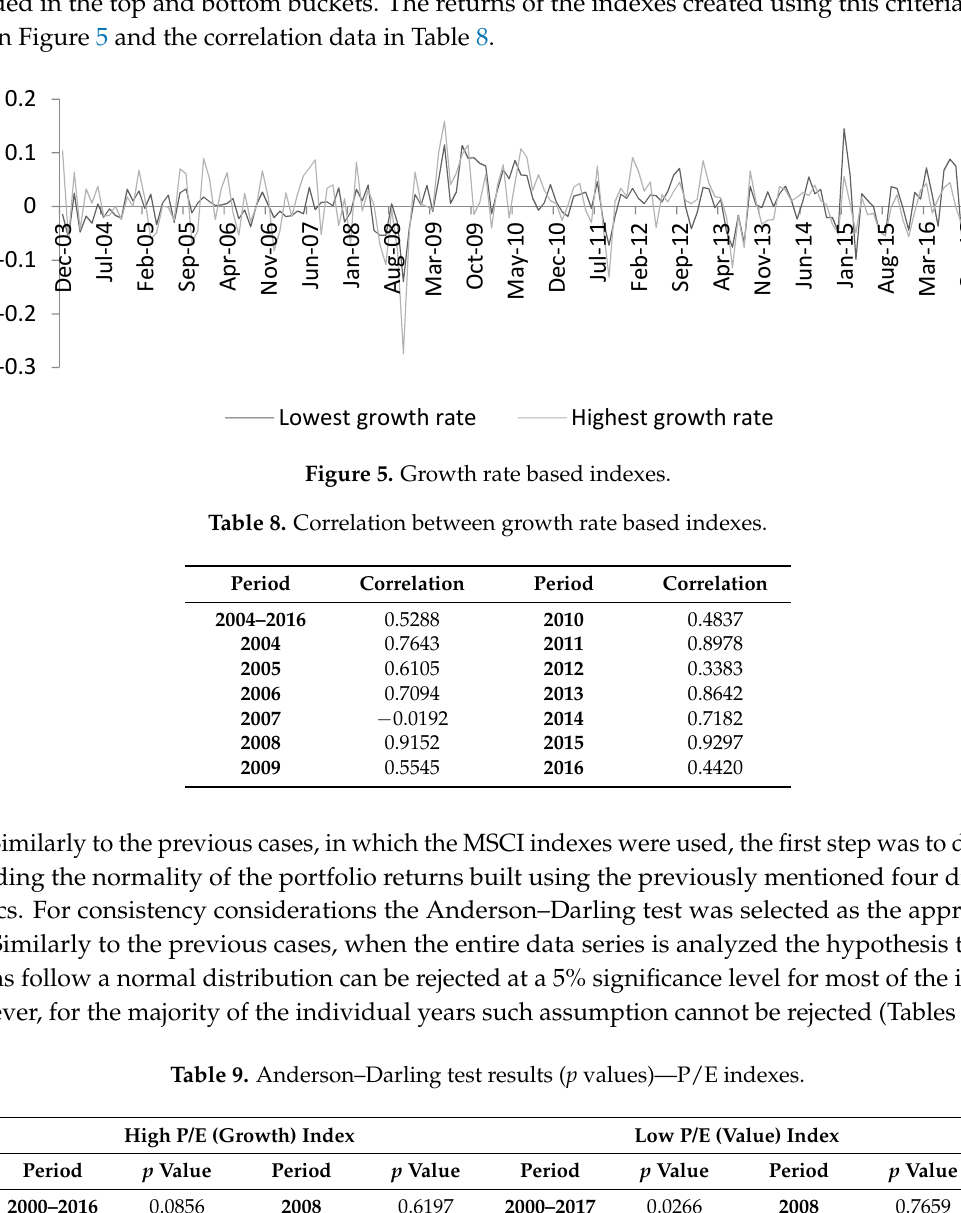
8 of 12 Figure 4. Price-to-book value indexes. Table 7. Correlation between price-to-book based index. Period